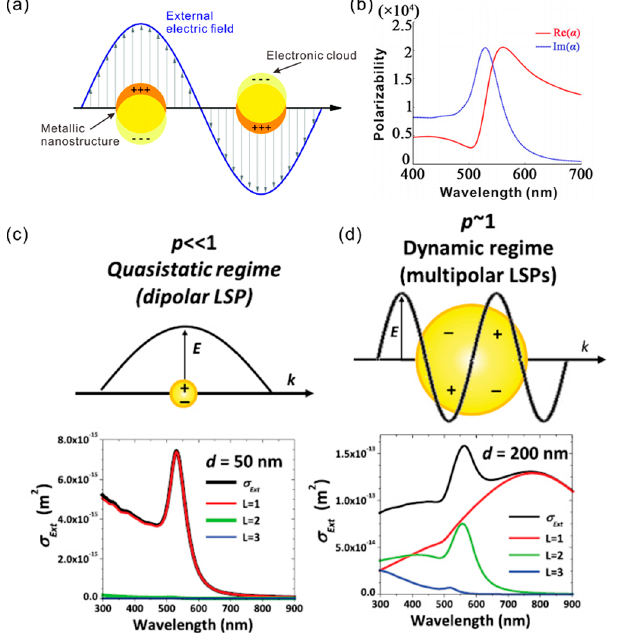
Figure 1. ( a ) Graphical illustration of localized surface plasmon resonance (LSPR) in metallic nanoparticles (NPs). ( b ) The polarizability curve of Au NPs with a diameter of 40 nm in water. ( c , d ) Contribution of dipolar (red), quadrupolar (green), and octupolar (blue) LSPR to the σ Ext (black) in Au NPs with size of 50 nm ( c ) and 200 nm ( d ). Adapted from [2], with permission from © 2017 IOP Publishing .